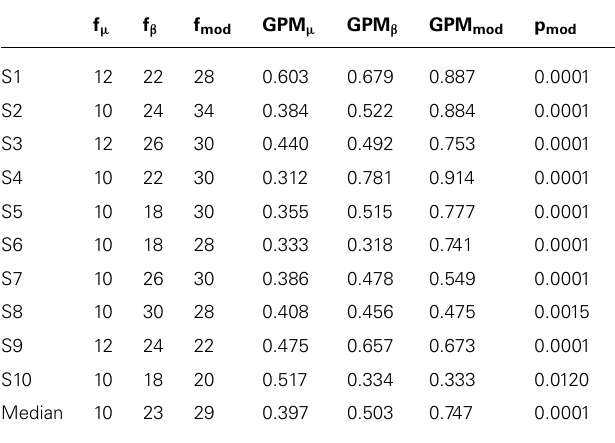
Table 1 | μ , β rhythm and modulation center frequencies (f) in Hz with the corresponding GPM values.